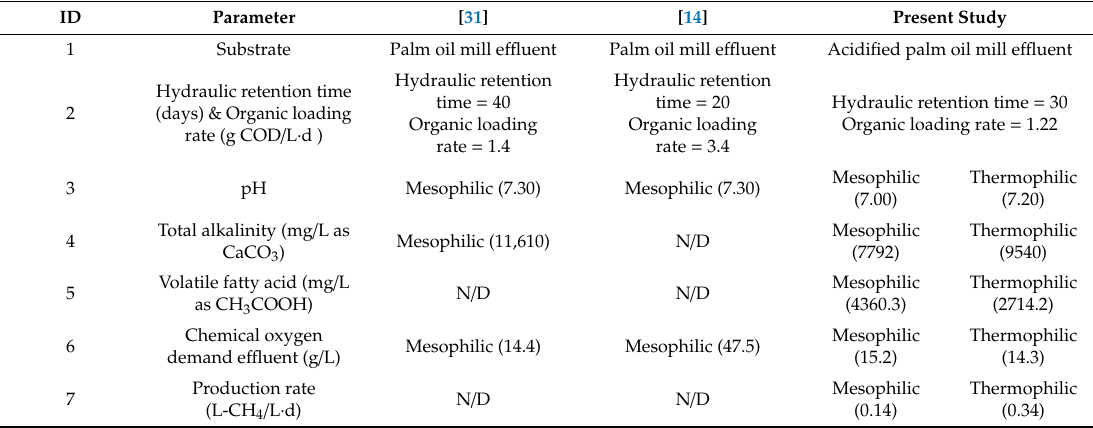
Table 2. Comparison of previous studies on acclimatization anaerobic digestion of methane from palm oil mill e ffl